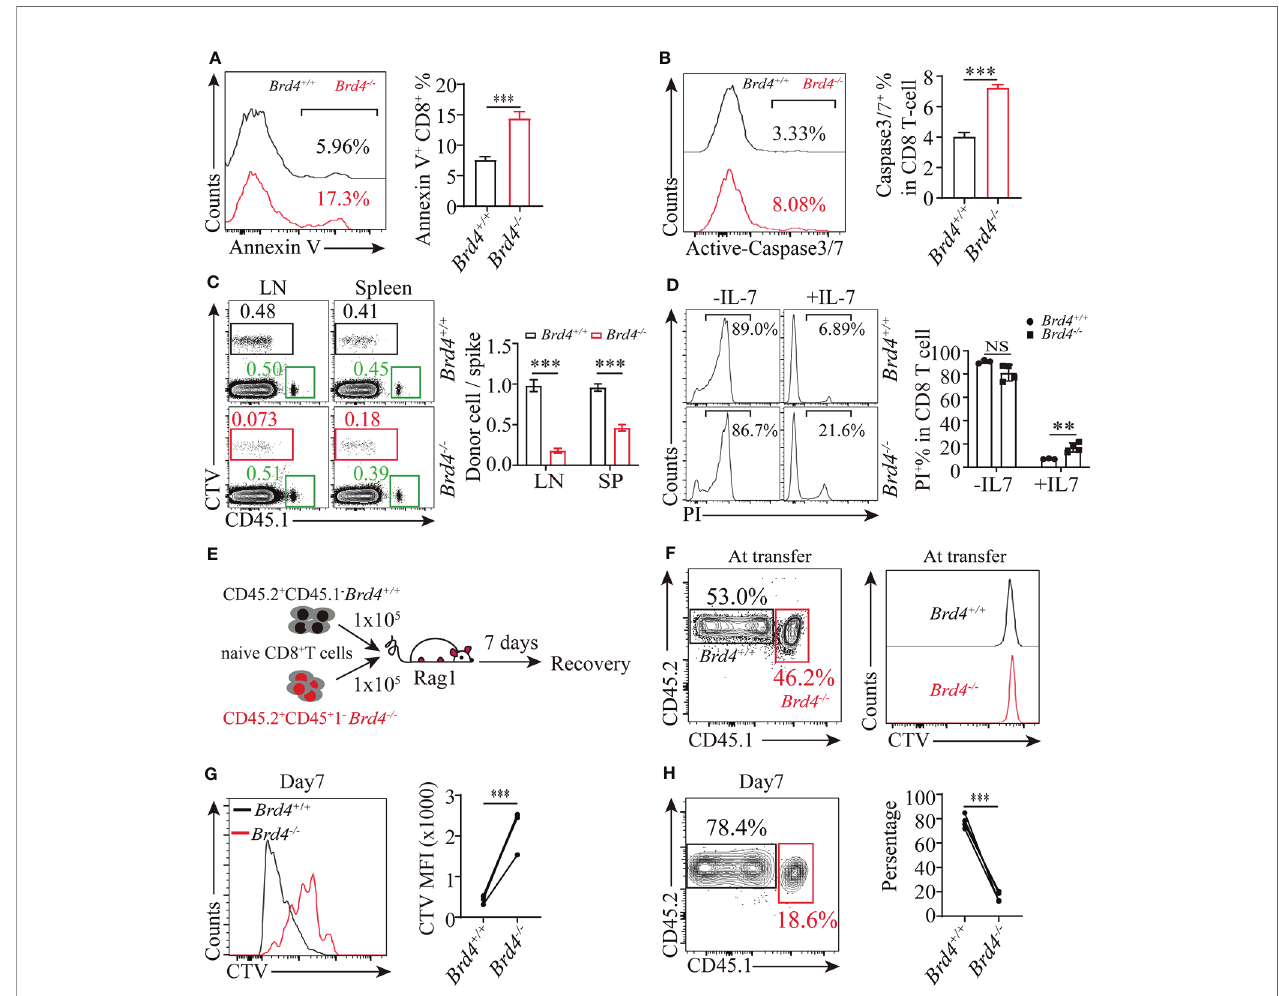
FIGURE 2 | Brd4 is essential for naïve CD8 + T cells survival and homeostasis proliferation. (A) Flow cytometry showing the frequency (left) and quanti fi cation (right) of Annexin-V + CD8 + T cells. (B) Flow cytometry showing the frequency (left) and quanti fi cation of active-caspase3/7 + CD8 + T cells (right). (C) Puri fi ed Brd4 +/+ and Brd4 -/- naïve CD45.2 + CD8 + T cells were labeled with CellTrace Violet (CTV) and respectively transferred with naïve CD45.1 + CD8 + T cells (spike) into CD45.2 + recipient mice to monitor the survival capability of naïve CD8 + T cells for 7 days in vivo . Flow analysis of donor naïve CD8 + T cells in spleen and lymph node at day 7 post-transfer (left) and the relative ratio of recovered donor cells to spike (right). (D) Sorted naïve CD8 + T cells from Brd4 -/- and Brd4 +/+ mice were cultured with or without IL-7 for 3 days to test IL-7 triggered survival effect. (E) Experimental setup. Congenically marked Brd4 +/+ and Brd4 -/- naïve CD8 + T cells were labeled with CTV, mixed at a 1:1 ratio, and then transferred into Rag1 mice to monitor cell proliferation at day 7 post-transfer. (F) Relative frequency of donor cells at transfer. (G) Representative fl ow analysis of donor cells recovered at day 7 post-transfer. (H) The quanti fi cation of donor CD8 + T cells at day 7 post transfer. Two-tailed unpaired t -test was used to analyze two independent groups, while paired Student ’ s t -test was used when sample being compared from same mouse. Results were indicated as mean ± sem (error bars). **p < 0.01; ***p < 0.001. NS, not signi fi cant. Each group includes at least 3 mice and each experiment repeats more than 3